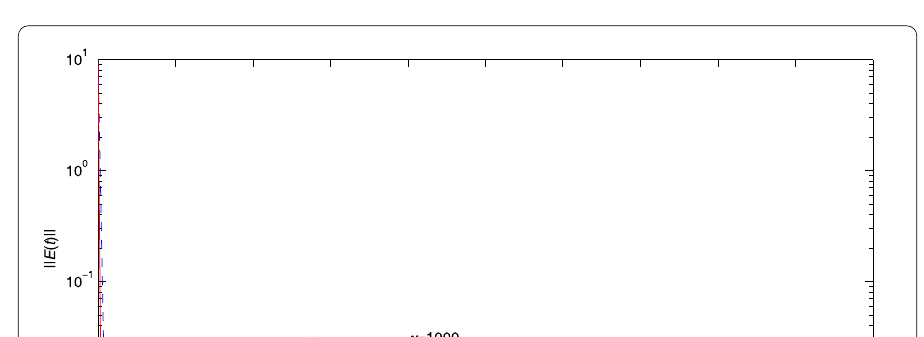
more CPU time because the larger the design parameter is, the smaller the step-size of ode45 is. In fact, the CPU times of NTCTZNN2 with γ γ 1 = 2 = 10 and NTCTZNN2 with γ 1 = γ 2 = 100 are 1.4219 and 1.8594, respectively. Comparing Figs. 2 and 3, we find that: (1) NTCTZNN2 with γ 1 = γ 2 = 10 is more efficient than NTCTZNN1 with γ γ = 1000, because the final residual error generated by NTCTZNN2 with γ 1 = 2 = 10 is about 10 –4 , while the final residual error generated by NTCTZNN1 with γ = 1000 is about 10 –3 ; (2) the final residual error generated by NTCTZNN1 becomes stable quickly, but the final residual error generated by NTCTZNN2 is shrinking during the tested time period [0,10], which is in accordance with Theorem 3.2. Overall, NTCTZNN2 can get more accurate solution but not increase the computational cost. The neural states X ( t )(1,1,1,1), X ( t )(1,2,1,2), X ( t )(2,1,2,1), X ( t )(2,2,2,2) computed by NTCTZNN2 are plotted in Fig. 4, which shows that the neural states converge to the corresponding